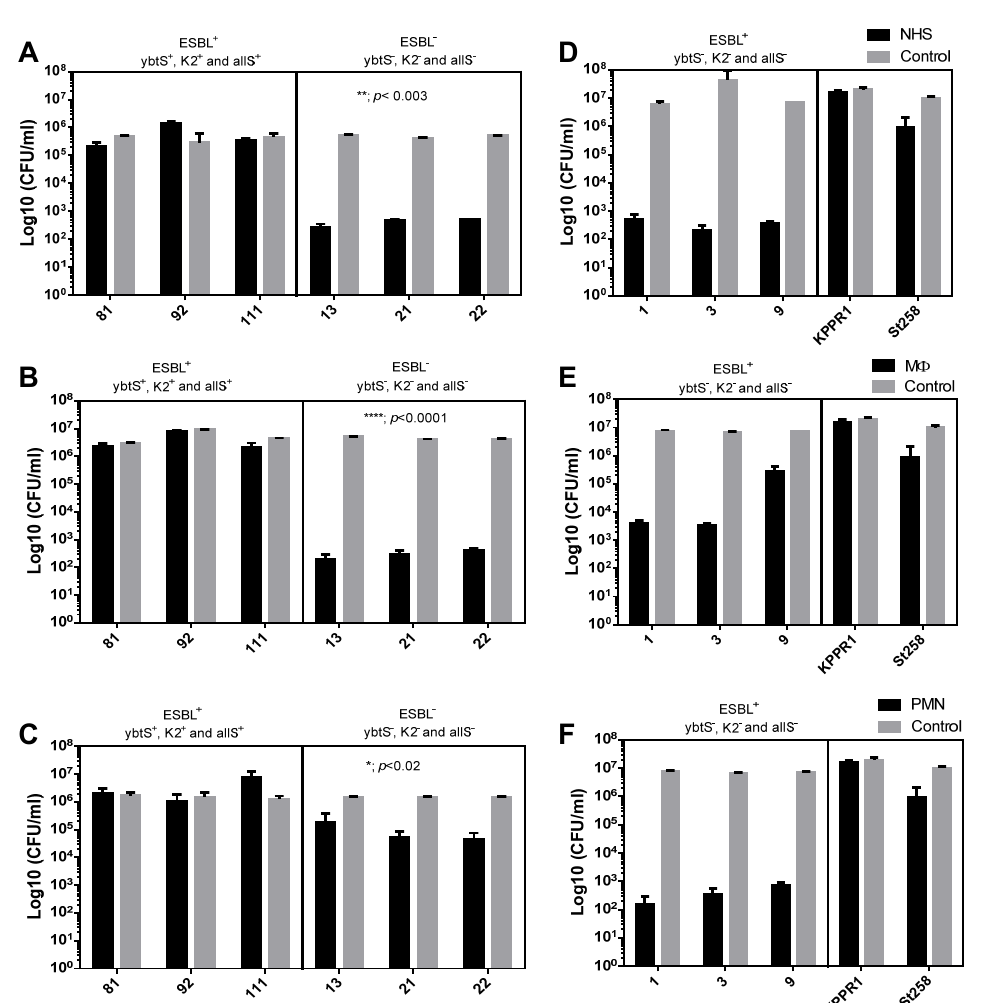
Figure 3. Effect of virulence genes on the susceptibility of ESBL or non-ESBL strains to components of innate immunity. The susceptibility of ESBL-producing K. pneumoniae clinical isolates bearing the virulence genes ybt S + , K2 + , and all S + was determined and compared with non-ESBL producing bacteria that lack the virulence genes. ( A , D ) Susceptibility to normal human serum (NHS), ( B , E ) susceptibility to phagocytosis by macrophages (M Φ ), and ( C , F ) susceptibility to phagocytosis by polymorphonuclear cells (PMN). The results of two independent experiments performed in triplicate are shown (n = 6). Viable bacteria were enumerated by colony count on ca-MH agar after serial micro-dilution. The colony forming units (CFUs)/mL values are presented as means +/ − SD, on a log 10 scale of treated bacteria (black bars) compared to untreated control bacteria (gray bars). **** = p < 0.0001, ** = p < 0.003 and * = p < 0.02 of two-way ANOVA comparing the proportion of treated/untreated ESBL bacteria with non-ESBL bacteria.